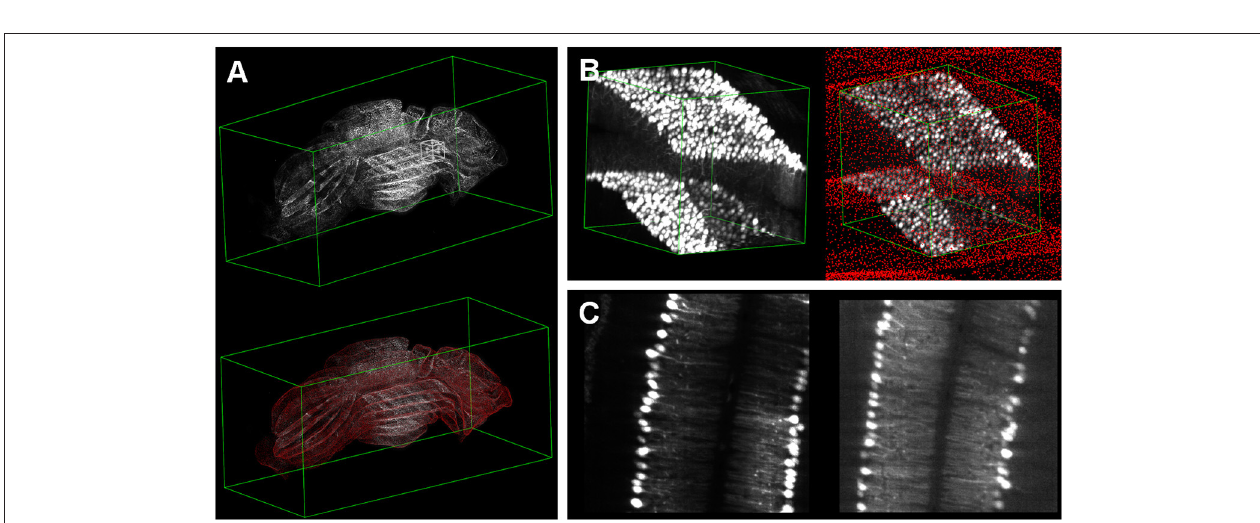
FIGURE 9 | Visualization of whole mouse cerebellum: (A) 3D visualization of the whole dataset with low resolution and Purkinje cells; (B) 3D visualization of a VOI selected from the interactive window in (A) ; (C) MIP and slice modes displaying the VOI.